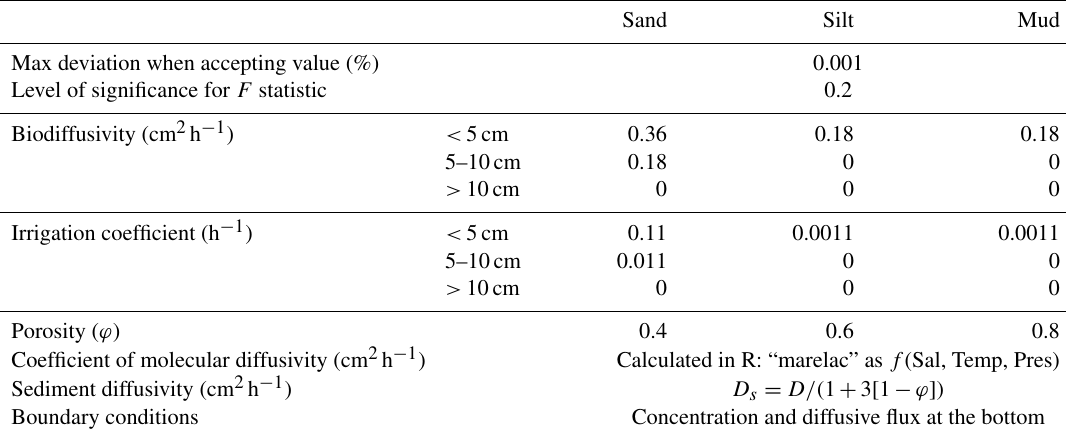
Table 1. Parameterization of the PROFILE